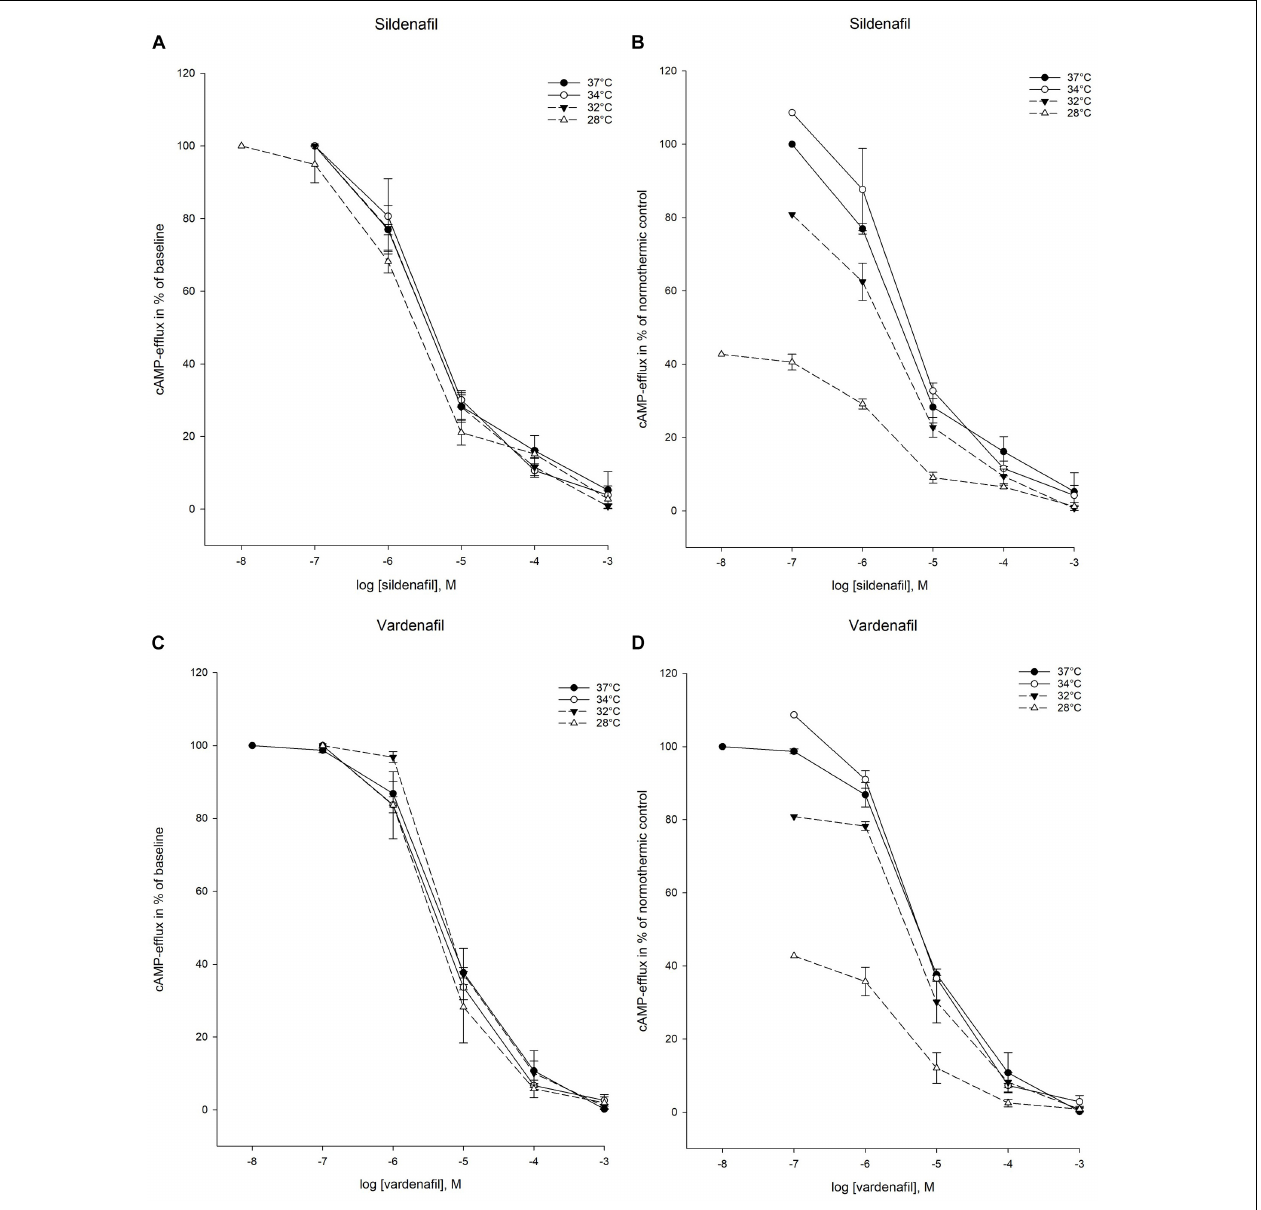
FIGURE 5 | Temperature-dependent inhibition of cAMP-efflux in inside-out vesicles (IOV). (A) Sildenafil inhibition curves for ABCC4-activity at temperatures ranging from 37 ◦ C to 28 ◦ C. The doses of sildenafil are in logarithm of the concentration in mol/L. (B) Inhibition curves for ABCC4-activity by sildenafil in % of normothermic inhibition curve at temperatures ranging from 37 ◦ C to 28 ◦ C. The doses of sildenafil are in logarithm of the concentration in mol/L. (C) Vardenafil inhibition curves for ABCC4-activity at temperatures ranging from 37 ◦ C to 28 ◦ C. The doses of vardenafil are in logarithm of the concentration in mol/L. (D) Inhibition curves for ABCC4-activity by vardenafil in % of normothermic inhibition curve at temperatures ranging from 37 ◦ C to 28 ◦ C. The doses of vardenafil are in logarithm of the concentration in